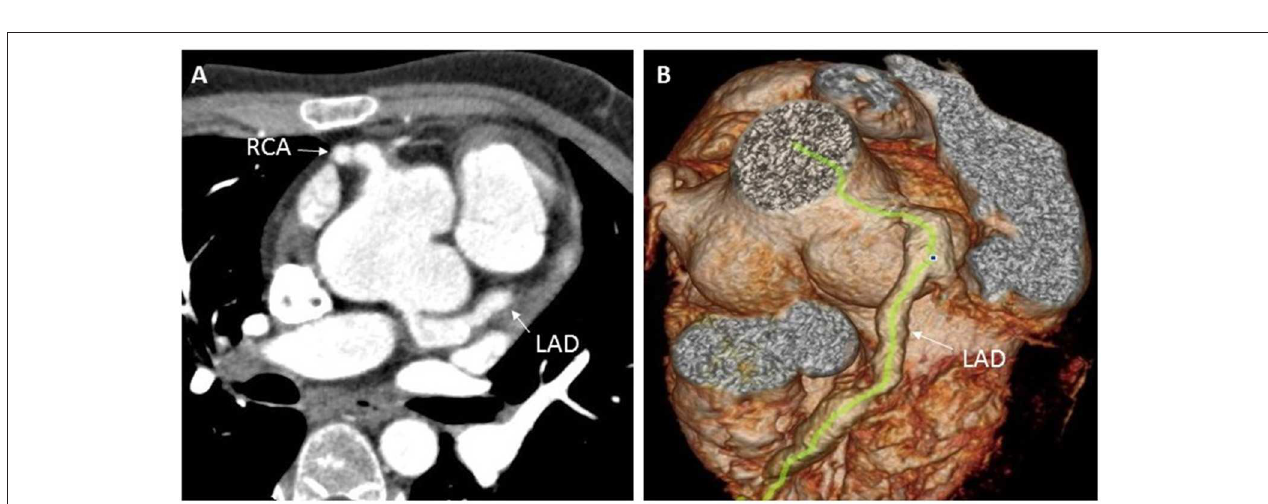
FIGURE 2 | Echocardiogram (apical four-chamber view) at the onset of pulmonary arterial hypertension at 9 years of age, showing severe tricuspid regurgitation (A) and continuous wave doppler estimation of tricuspid reflux velocity 3.88 m/s, PG = 60 mmHg (B) .